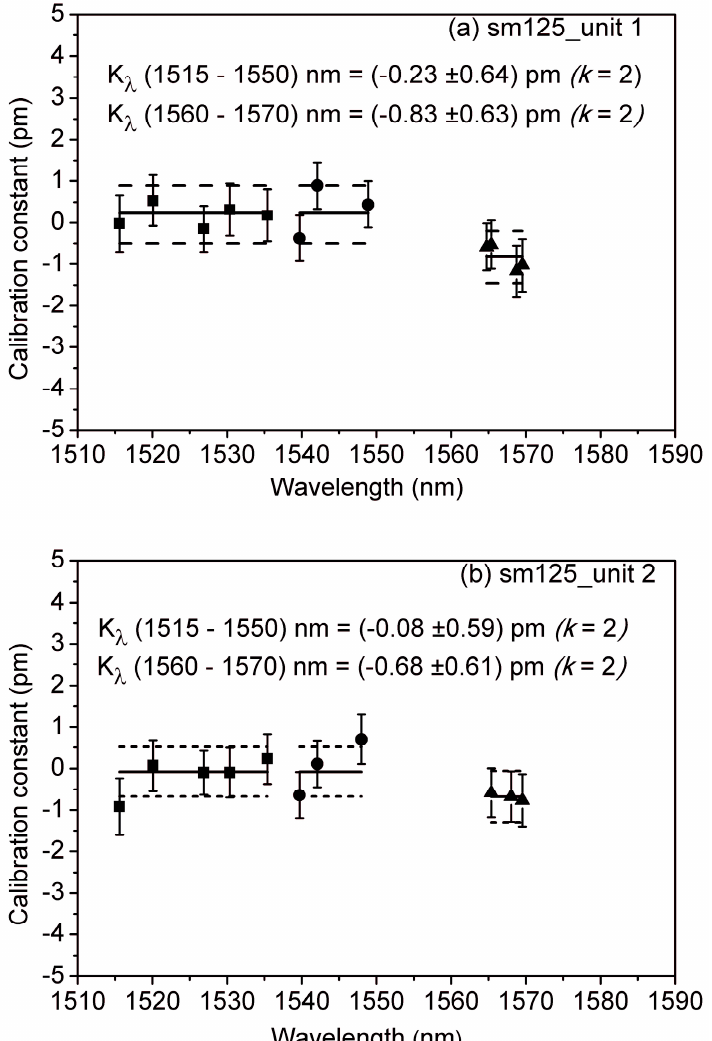
Figure 6. Correction constants with wavelength-dependent uncertainties for the devices under test, as determined by the second calibration method, using acetylene (squares), hydrogen cyanide (circles), and carbon monoxide 12 C 16 O (triangles) gas absorption cells: ( a ) sm125-500 unit 1; ( b ) sm125-500 unit 2. The mean correction constants (solid line) and expanded uncertainties ( k = 2, dashed line) are also depicted. Table 5. Mean correction constants and expanded uncertainties ( k = 2) for the four commercial systems calibrated.